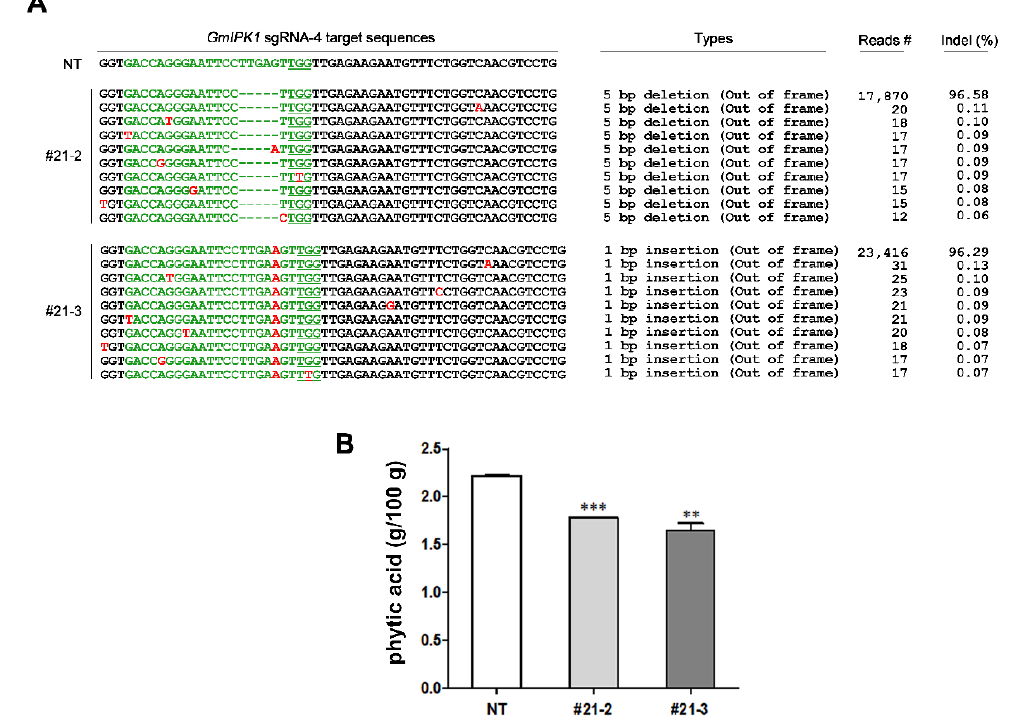
Figure 6. Inheritability of CRISPR/Cas9-induced mutations in Gmipk1 gene-edited transgenic soy- bean plants. ( A ) Indel mutation patterns and ratios in T 1 progenies of T 0 plant. The mutation ratio (Indel %) was calculated by dividing the number of reads containing indels at the target site (Reads #) by the number of total sequencing reads. The protospacer adjacent motif (PAM) sequences (NGG) are bold and underlined. Insertions and deletions are represented by red font and green hyphens, respectively. ( B ) Total phytic acid contents in T 2 seeds of soybean Gmipk1 gene-edited lines #21-2 and #21-3. Phytic acid was measured in the mature T 2 seeds from each GE line #21-2 and #21-3. The symbols ** and *** indicate significant differences at p = 0.001 and 0.0001, respectively ( n = 3).